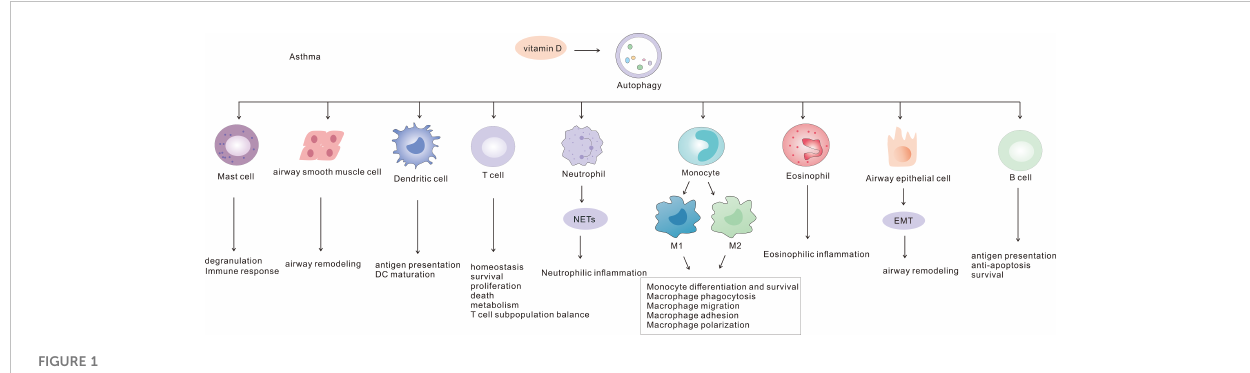
FIGURE 1 Mechanism of autophagy in